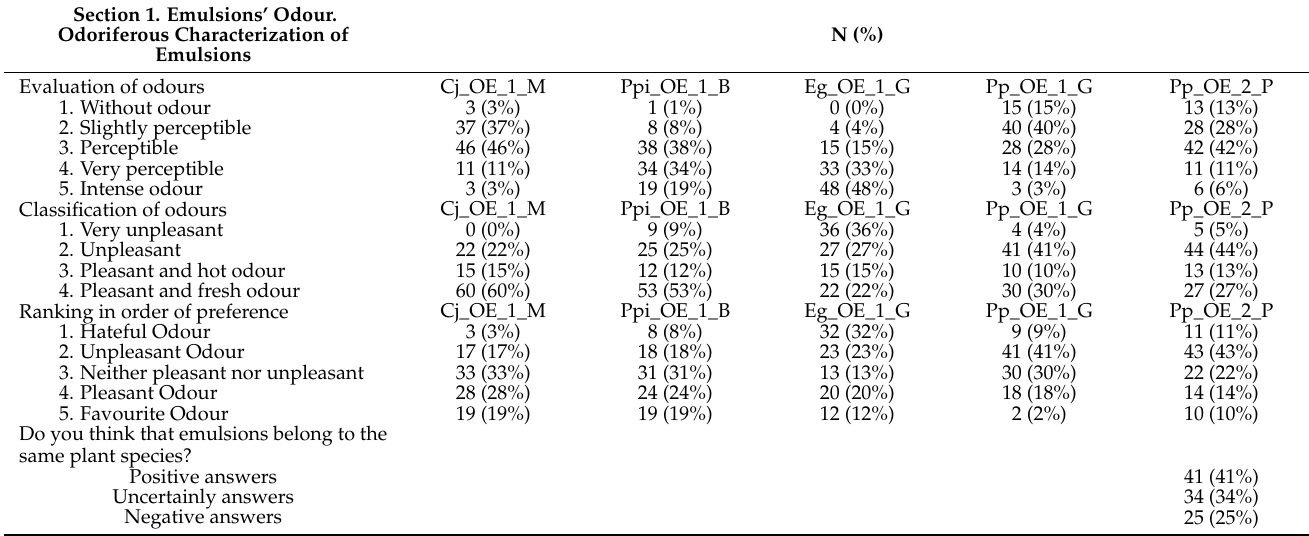
Table 6. Participants responses regarding the characterization of emulsions odour.